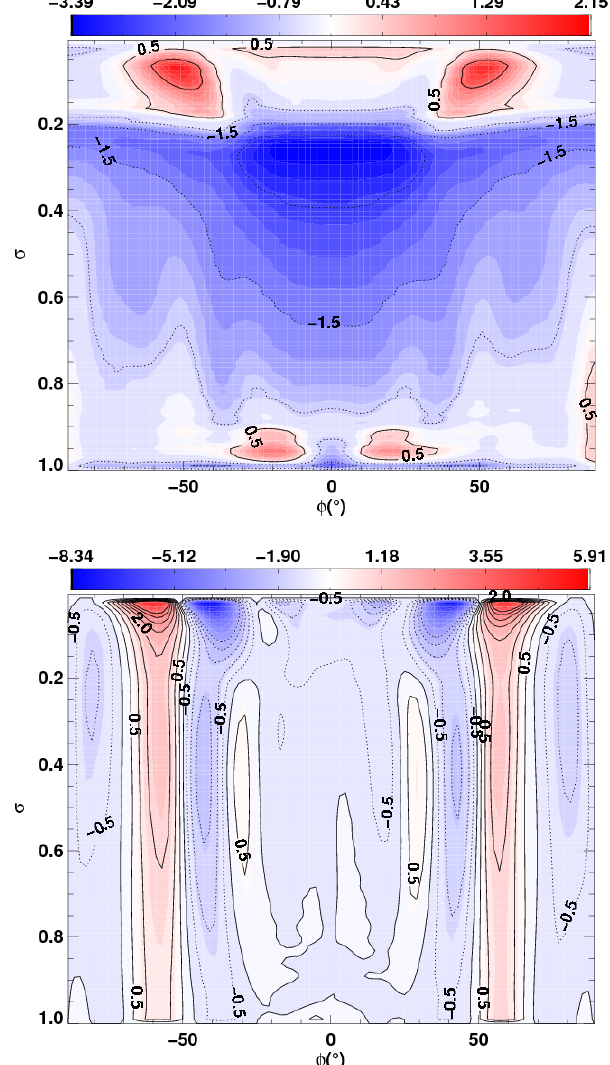
Figure 10. Figure, for the Earth-like test (Menou and Rauscher, 2009), showing the differences EG–ND of the zonally and tem- porally averaged temperature, top, and zonal wind (ms − 1 ) bottom Fig. 10. Figure, for the Earth–Like test (Menou and Rauscher, panel (see Table 2 for explanation of model 2009), showing the differences EG − ND of the zonally and tem- porally averaged temperature, top , and zonal wind (ms − 1 ) bottom panel (see Table 2 for explanation of model types).